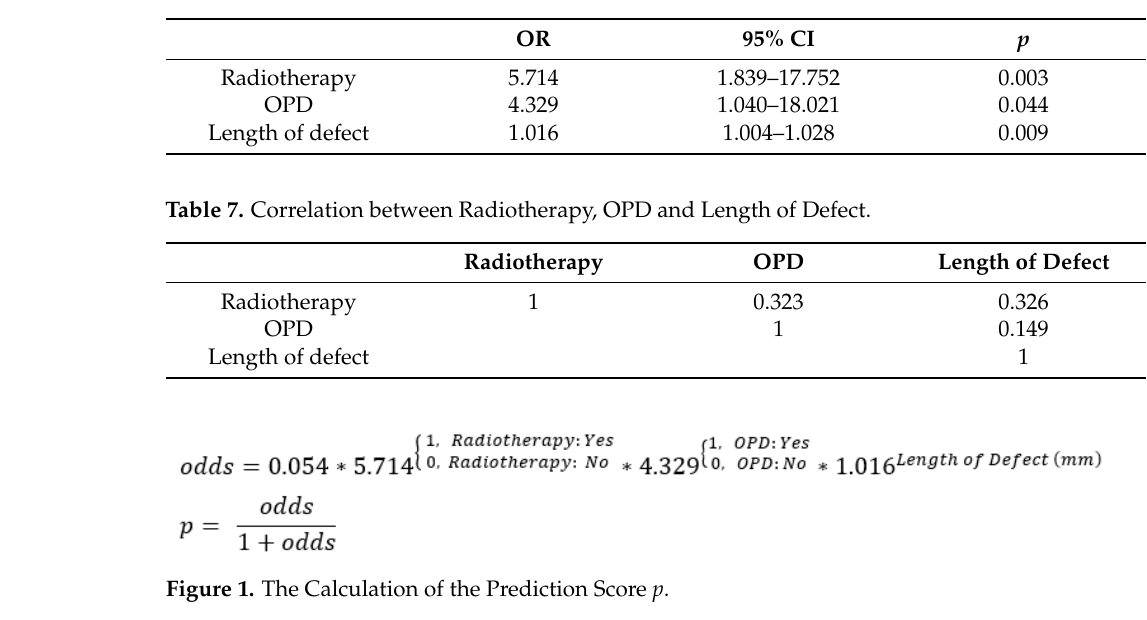
Table 6. Multivariate Analysis of Significant Risk Factors on Complication in the Univariate Analysis.